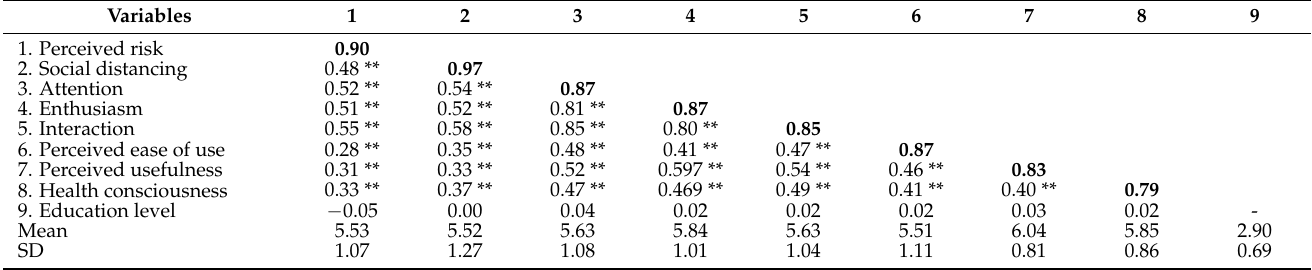
Table 3. Descriptive statistics and correlation matrix of variables.